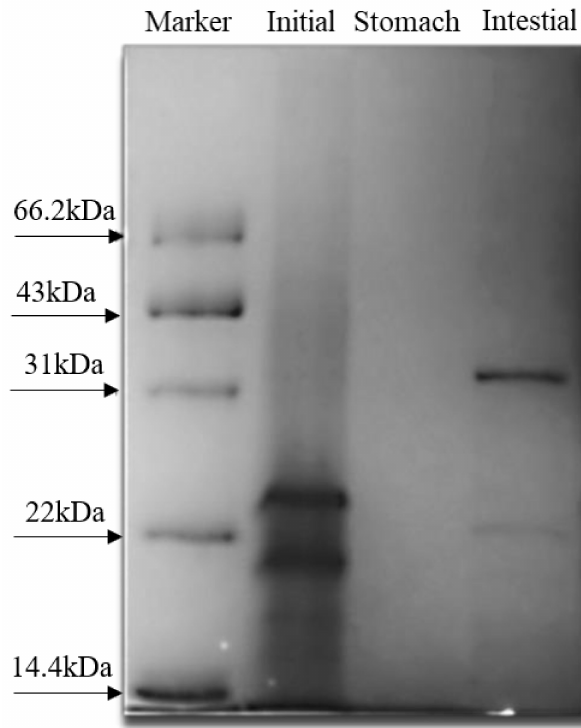
Figure 9. SDS-PAGE of the CaCO 3 S/O/W emulsions at different stages of